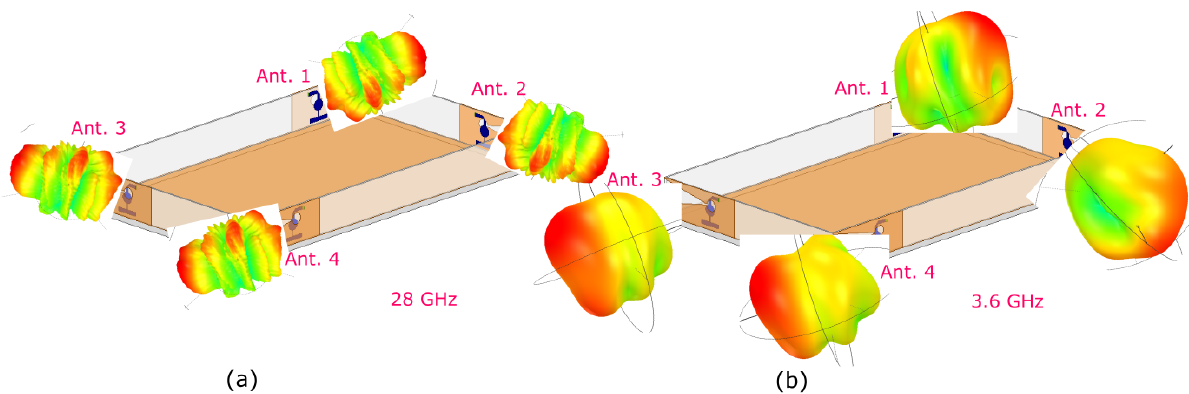
Figure 4. The 3D radiation patterns of the proposed MIMO antenna at ( a ) 28 GHz and ( b ) 3.6 GHz.